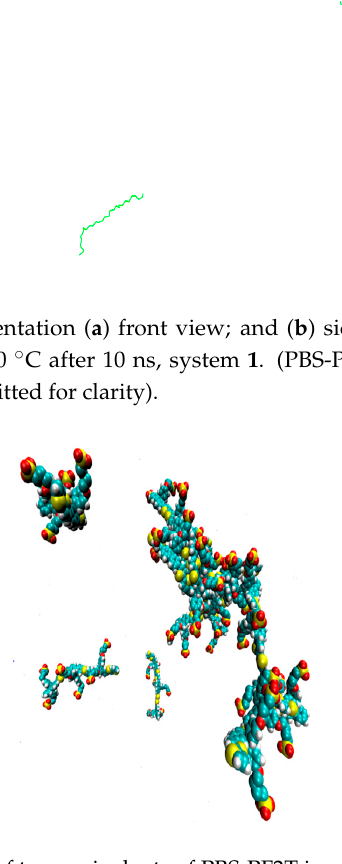
Figure 3. Simulation cell at 20 ns of ten equivalents of PBS-PF2T in water, PBS-PF2T in van der Waals representation [27].